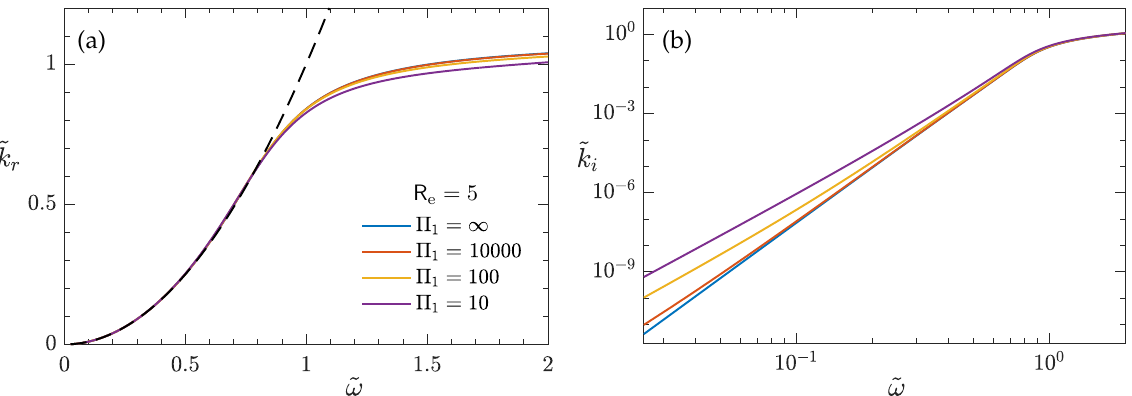
Figure 2. Dispersion relationship with R e = 5, varying the viscosity ratio Π 1 : ( a ) wavenumber ˜ k r ( ˜ ω ) , ( b ) the corresponding wave attenuation rate ˜ k i ( ˜ ω ) . In ( a ), the dashed curve is Lamb’s solution for two layers of inviscid fluids ( ν 1 = ν 2 = 0) of different